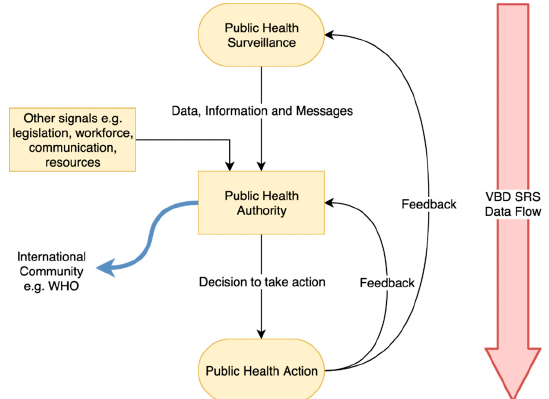
Figure 1. Vector Borne Disease Surveillance and Response System framework. Source: Adapted from McNabb et al. (2002) [24].